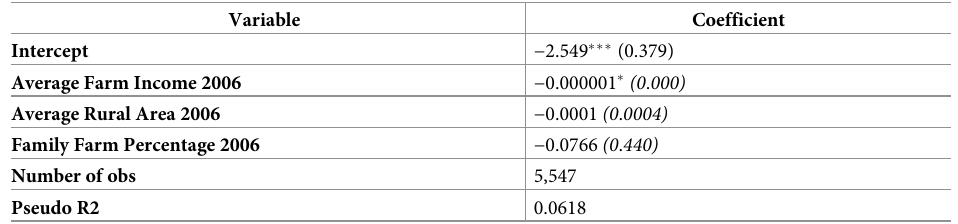
Table 3. Probit results: Municipalities with organic production hotspots.